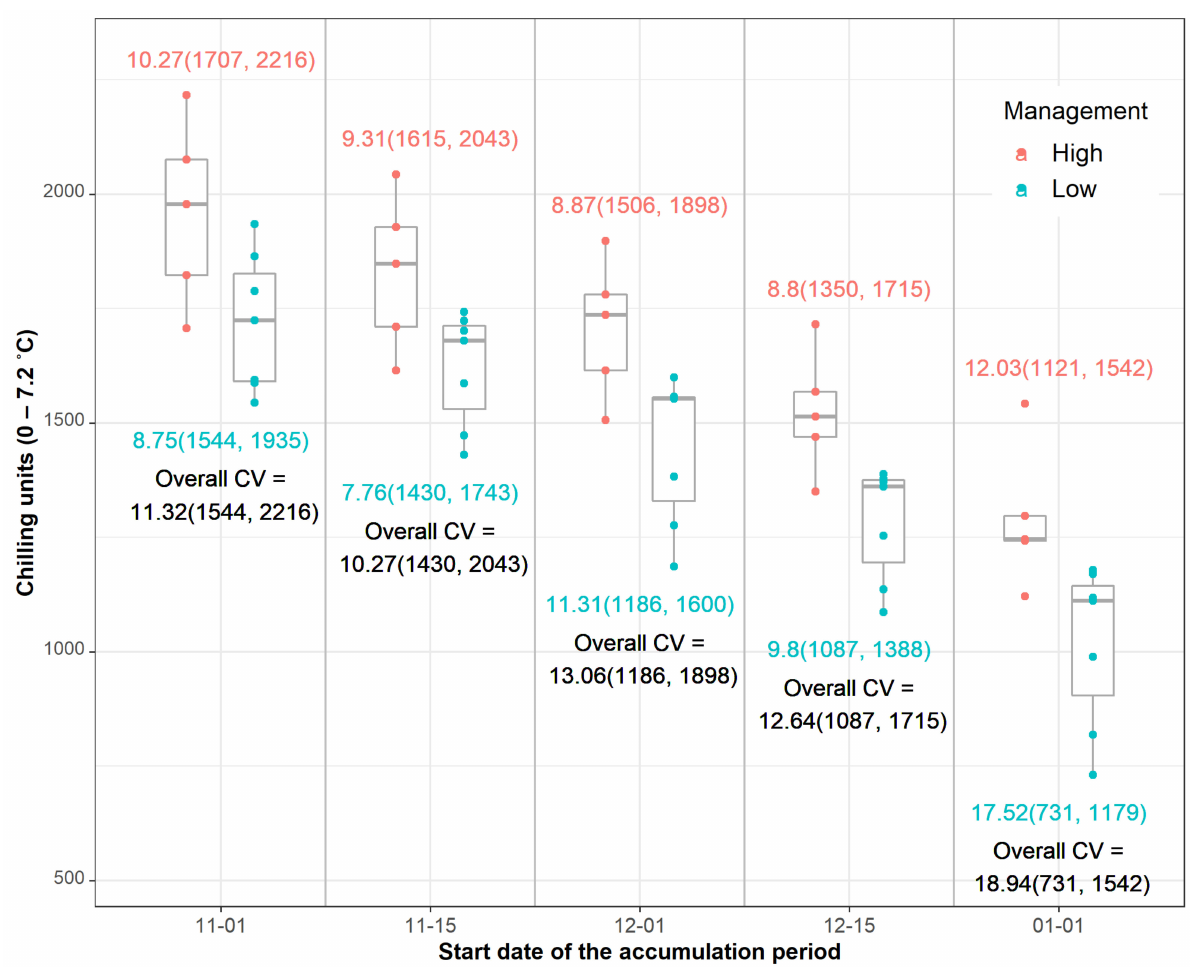
Figure 5. Accumulation of chill hours (hours with air temperatures between 0 and 7.2 ◦ C) between varying biofix dates and the initial date of apothecial presence for each management level in blueberry production systems in northwestern Washington. Numeric values represent the coefficient of variation (CV) and minimum and maximum value (in brackets) per management level (color-coded) or overall (black